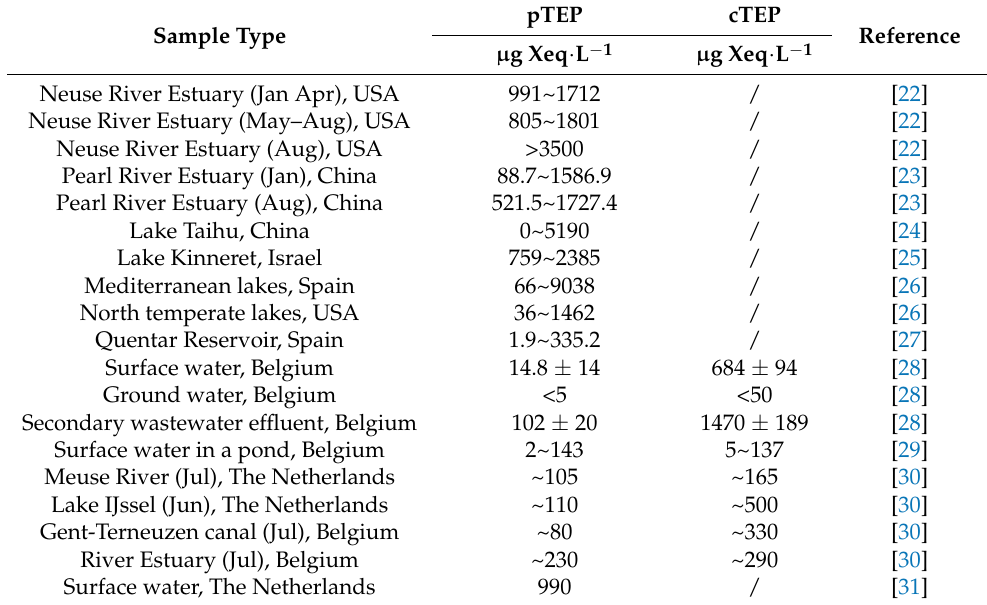
Table 1. Overview of TEP concentrations in fresh